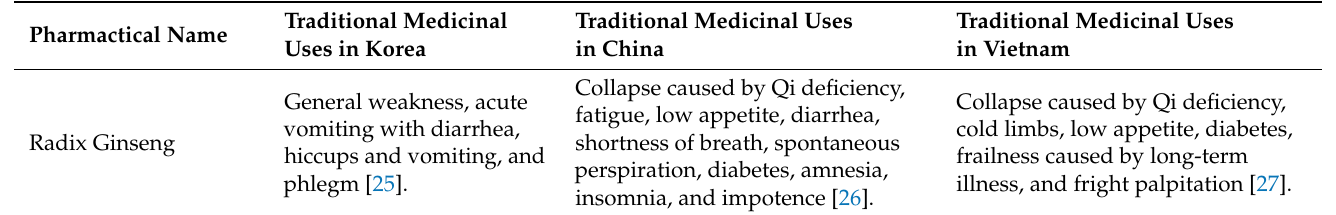
Table 2. Comparison of traditional use of 8 Qi-invigorating herbs in Korean, Chinese and Vietnamese